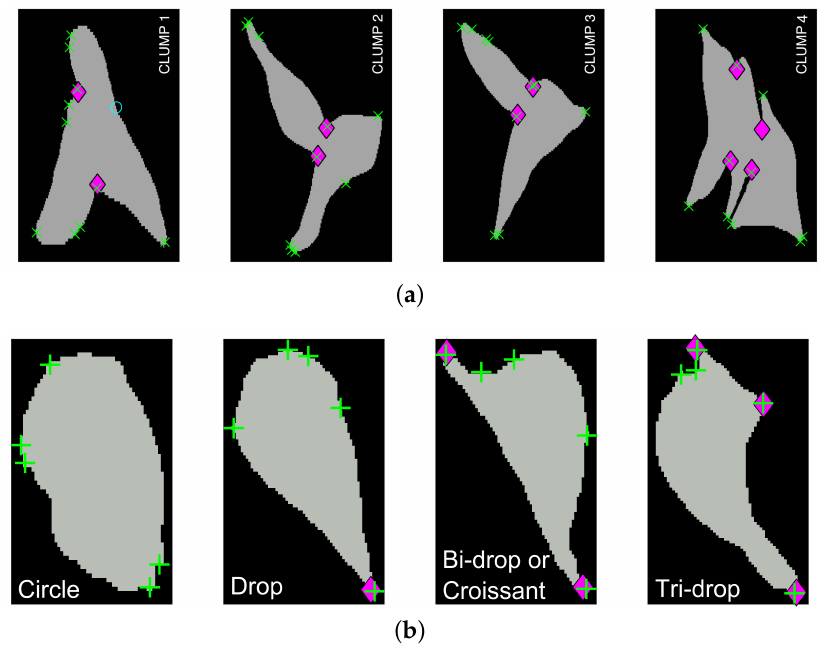
) versus the Harris Figure 11. Qualitative comparison of junction detection via anglegram (magenta (cid:5) corner detector (green + ). The strongest corners from the Harris detector per clump are displayed. ( a ) Only CLUMP 1 has a missing junction (cyan ), it should be noticed how difficult detection of the ◦ junction would be. [17] Reproduced with permission. ( b ) Each basic shape in the data is represented from a segmented frame. Refer to Section 2.3 for a full explanation of the corner detection